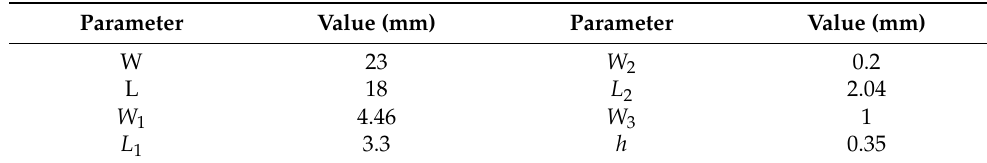
Figure 2. Conventional textile antenna. ( a ) Dimension of the textile antenna. ( b ) Simulation and measurement of the return loss S 11 Table 1. Dimensions of the proposed antenna.